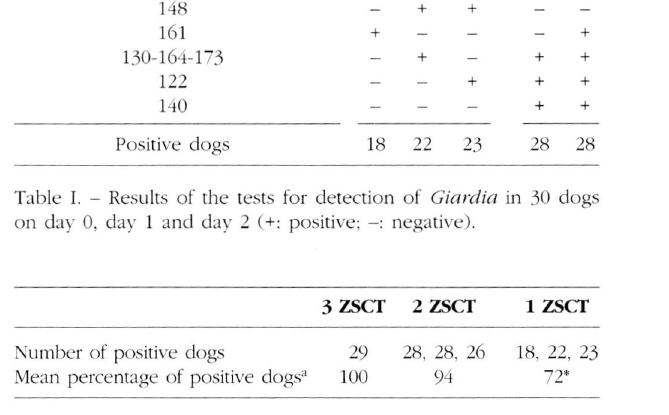
Table II. - Comparison of the sensibility of 1. 2 or 3 ZSCT for detec­ tion of Giardia. a We considered that a dog was positive if at least one of the three ZSCT was positive. * Significant difference between this result and 100 % (P < 0.05).